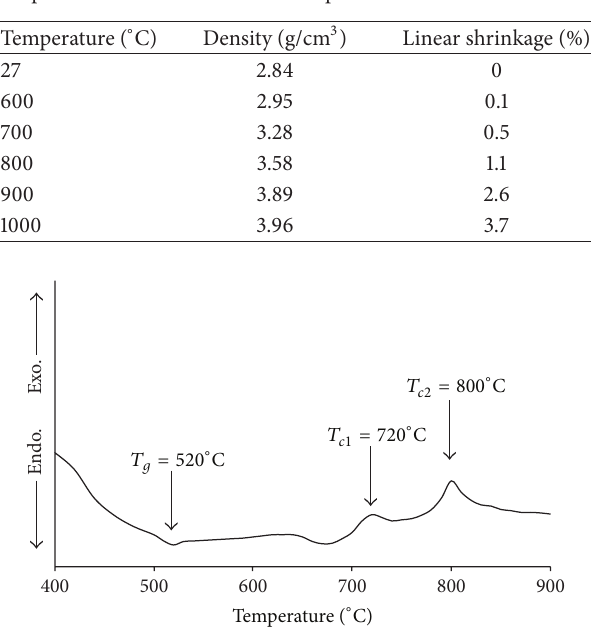
Table 2: The density and linear shrinkage of the glass-ceramic sample at various heat treatment temperatures.